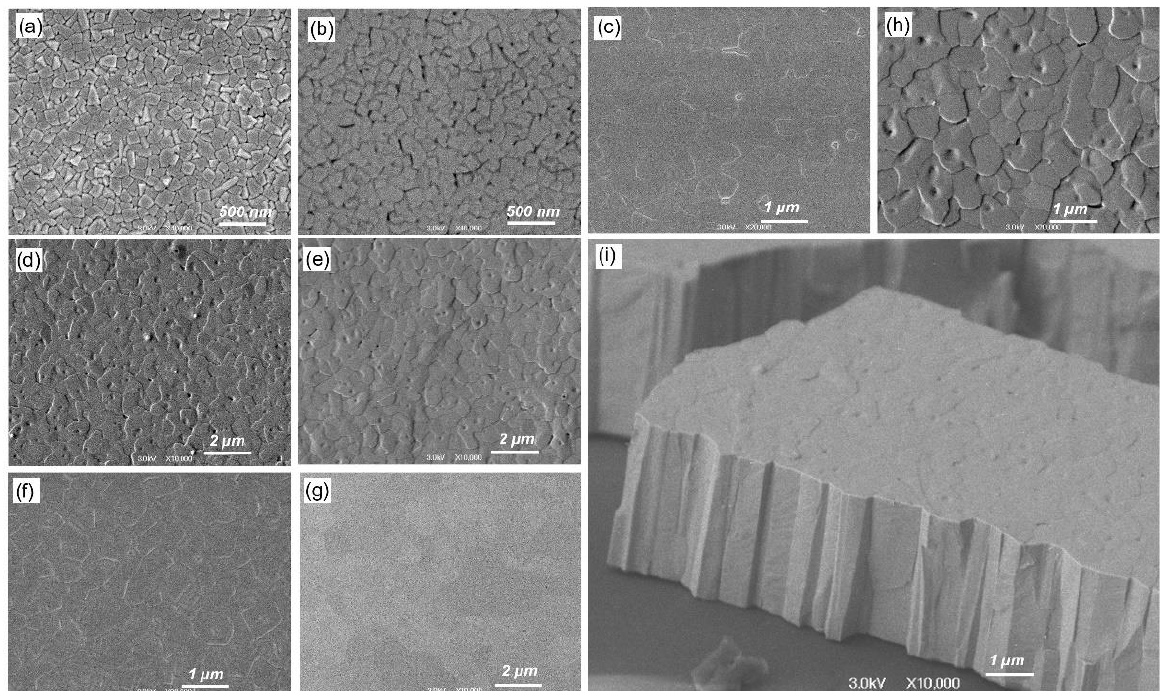
Figure 2. Structural properties of the grown PbTe:In films: ( a – c ) SEM image of evolution of the crystallite structure of Pb 0.99 In 0.01 Te films with a common thickness of 2 µ m grown on substrates at temperatures 523, 573, 638 K, respectively; ( d ) Grain size for as-grown Pb 0.995 In 0.005 Te film of 3 µ m thickness ( T S = 623 K) and ( e ) the same film after heat treatment, respectively; ( f , g ) SEM images of evolution of the crystallite structure of Pb 0.99 In 0.01 Te films with 3 µ m and 4 µ m thickness ( T S = 598 K), respectively; ( h ) Close up of the film surface shown in Figure 2e; ( i ) SEM image of a cross-section of as-grown Pb 0.995 In 0.005 Te film with 3 µm thickness ( T S = 623 K) showing its columnar structure.